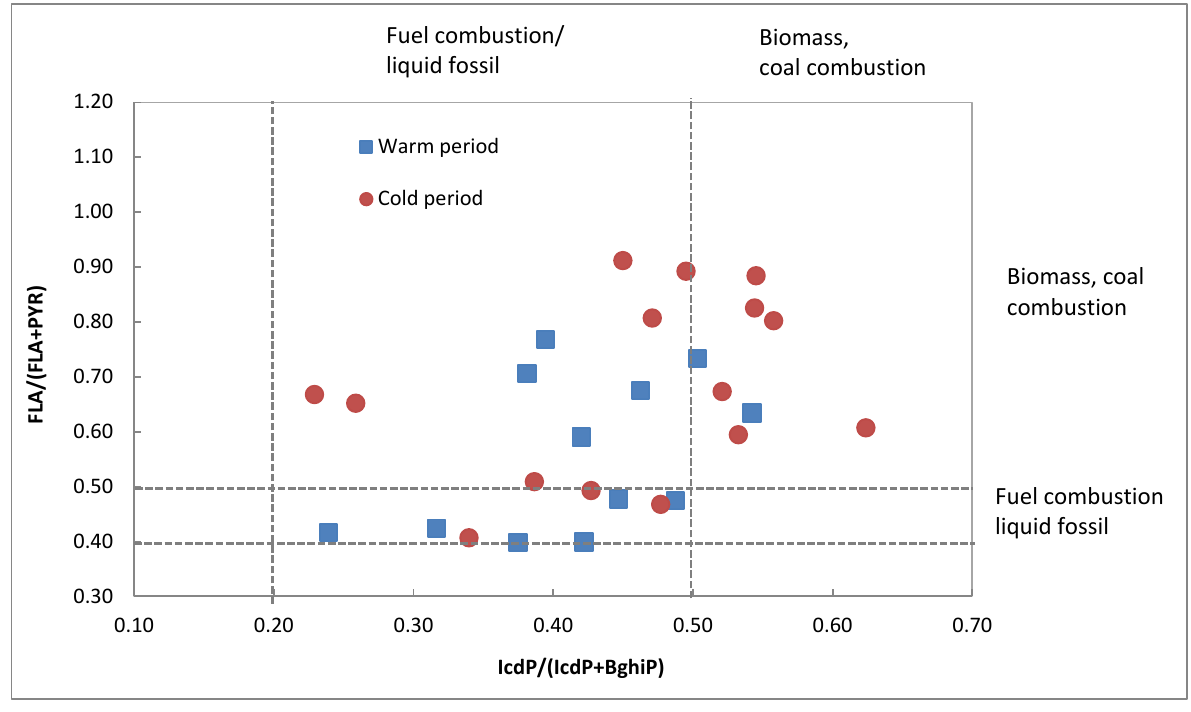
Figure 6. Ratio of FLA/(FLA + PYR) versus IcdP/(IcdP + BhiP) for the warm (16 May–23 October 2018 and 16 April–29